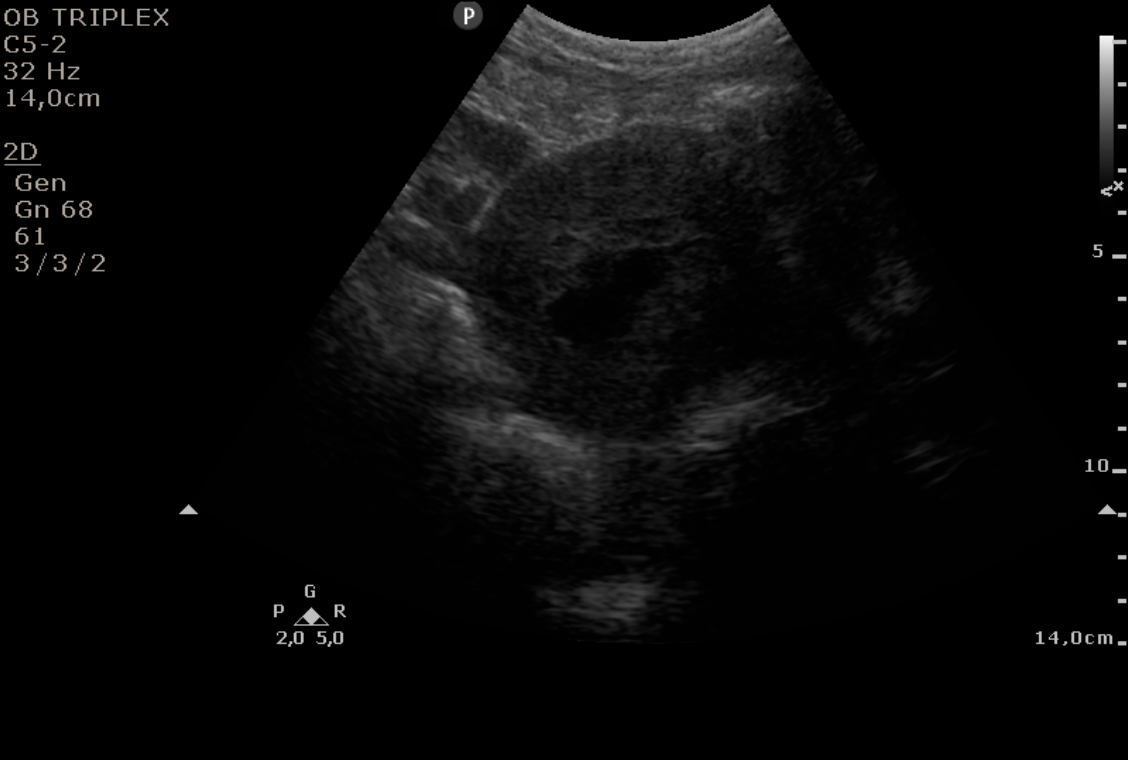
Figure 5. Grade 4: over three-quarters of the endometrial length occupied by blood or debris.